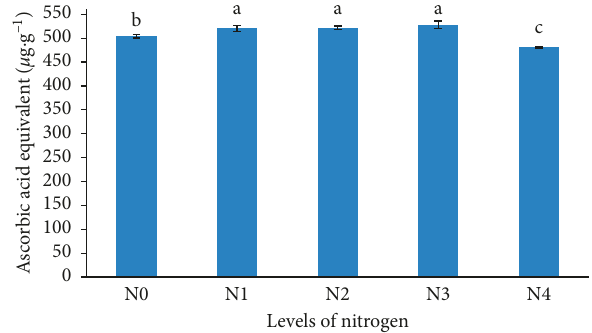
Figure 4: Effect of different levels of N on total antioxidant activity in hydromethanolic extracts of seeds of sesame. AA: ascorbic